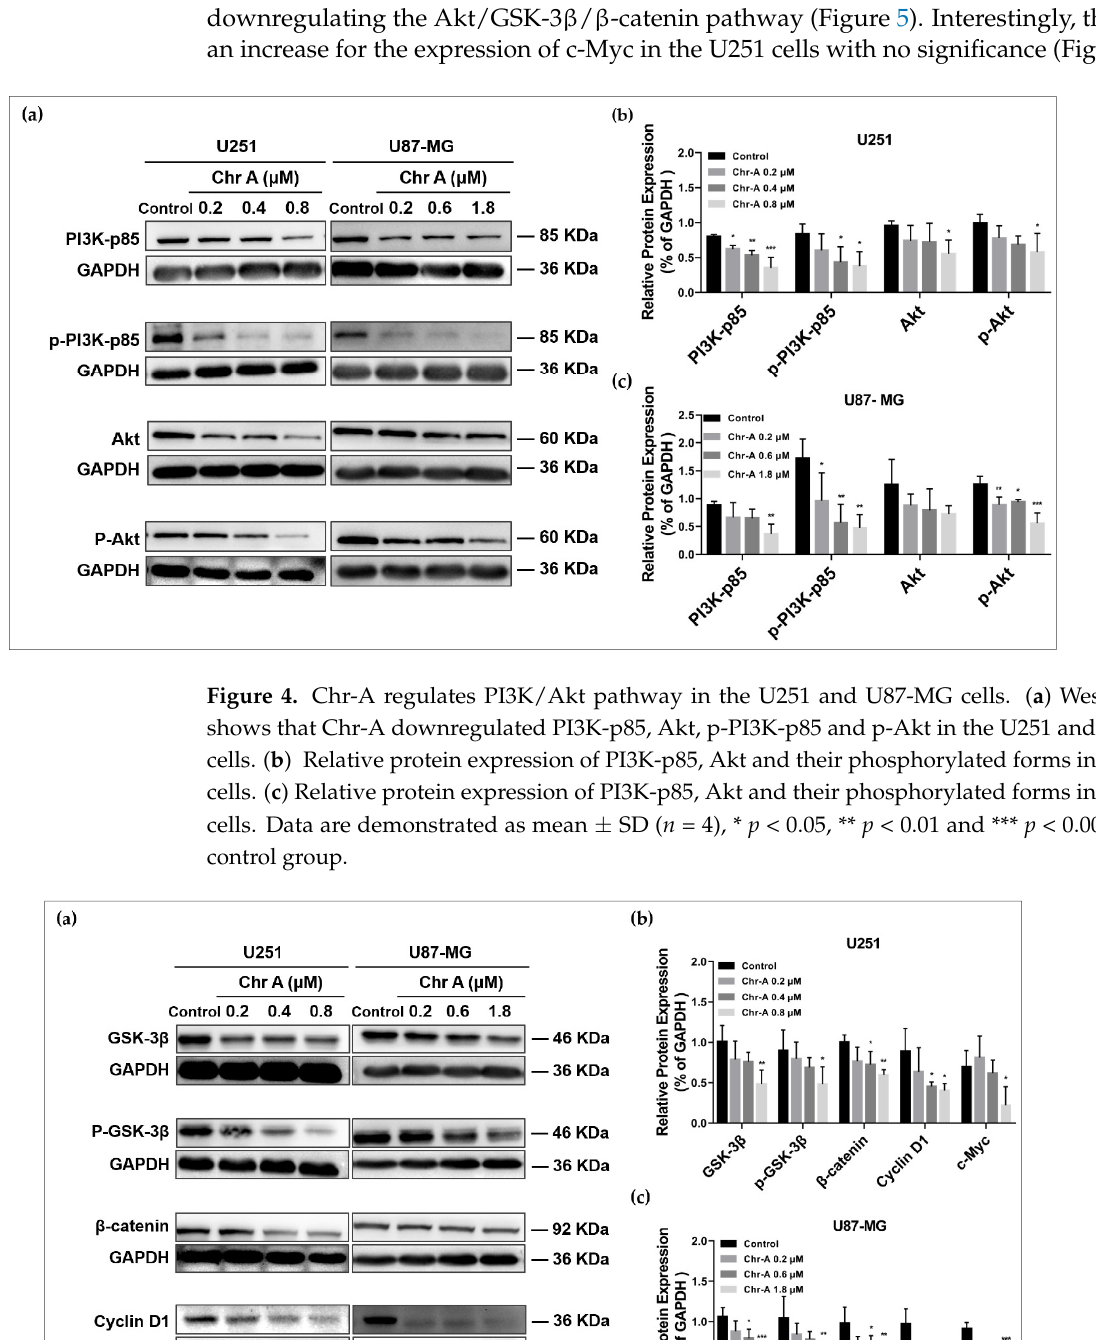
downregulating the Akt/GSK-3 β / β -catenin pathway (Figure 5). Interestingly, there was